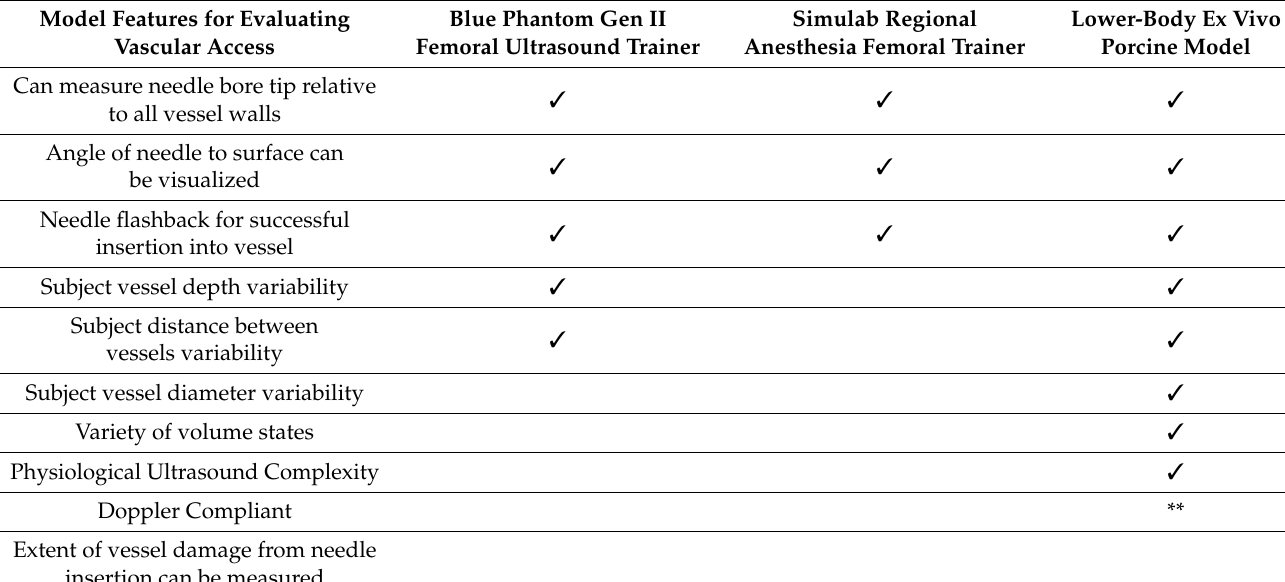
Table 1. Summary of each model platform’s ability for measuring key performance metrics for vascular access devices. Checkmark indicates model could successfully perform. ** was not evaluated, but likely can be